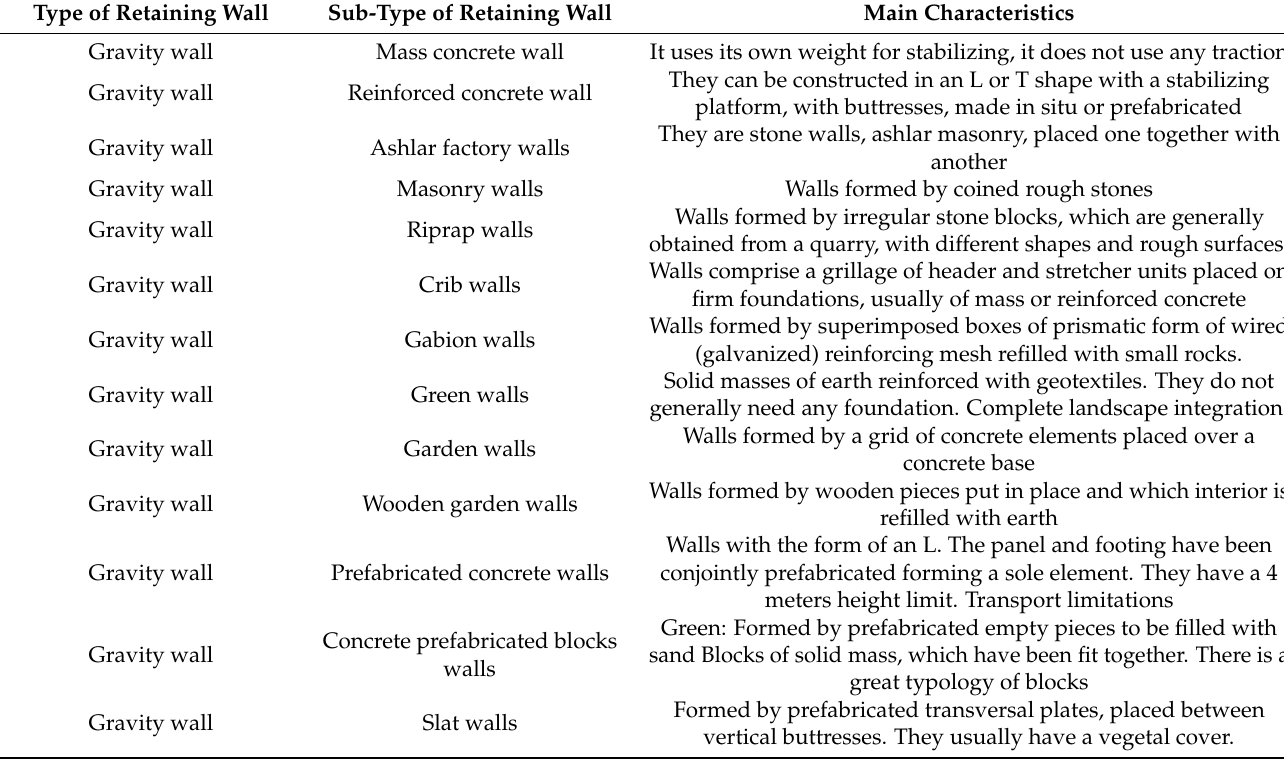
Table 1. Types of retaining walls. Source: the authors’ own